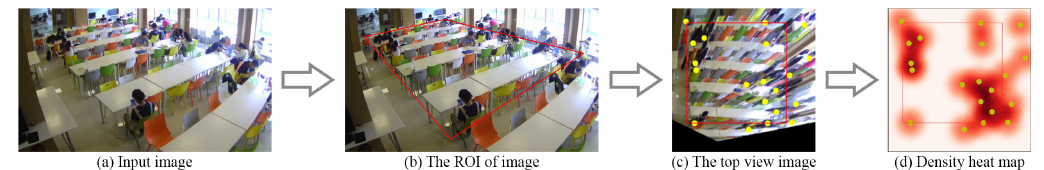
Figure 2. Perspective correction